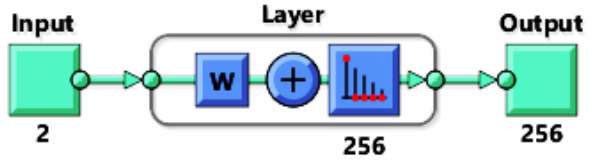
Figure 11. Neural net topology with 16